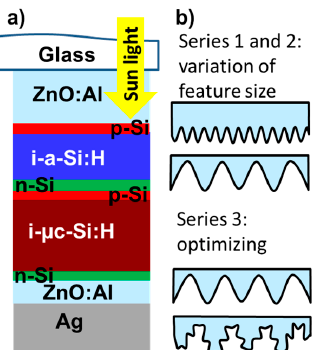
Figure 1. Layer stack of the solar cell on glass: aluminum doped zinc oxide front contact, amorphous silicon top cell, microcrystalline bottom cell, and ZnO:Al silver back reflector. The subcells consist of intrinsic silicon absorber sandwitched between p and n doped silicon ( a ), description of test series 1 and 2 for variation of feature size for discussion of the optics and series 3 for optimizing single and double textures ( b ).